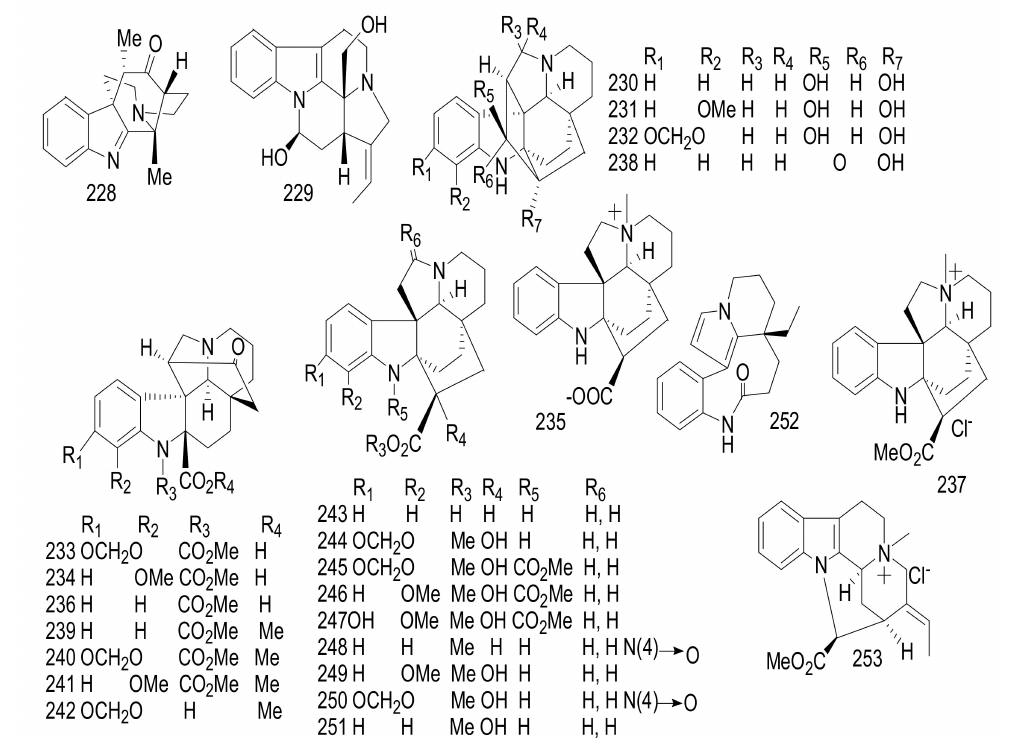
Figure 21. Compounds 228 – 253